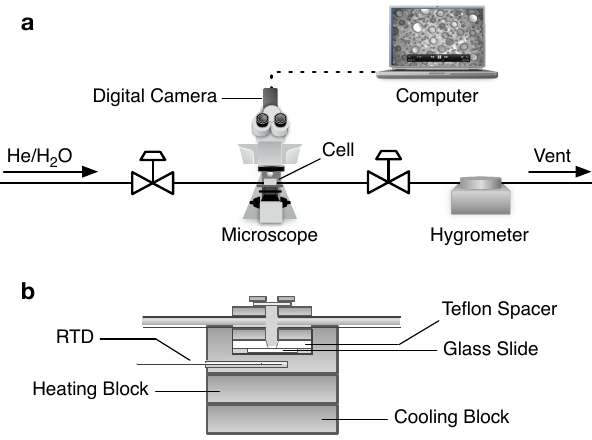
Fig. 1. Schematics of the optical microscopy technique coupled with a temperature-controlled cell and a CCD camera. Panel ( a ) indicates the basic arrangement of the instrumental components with relation to the gas flow of humidified He. Panel ( b ) provides a detailed view of the components that comprise the flow cell.